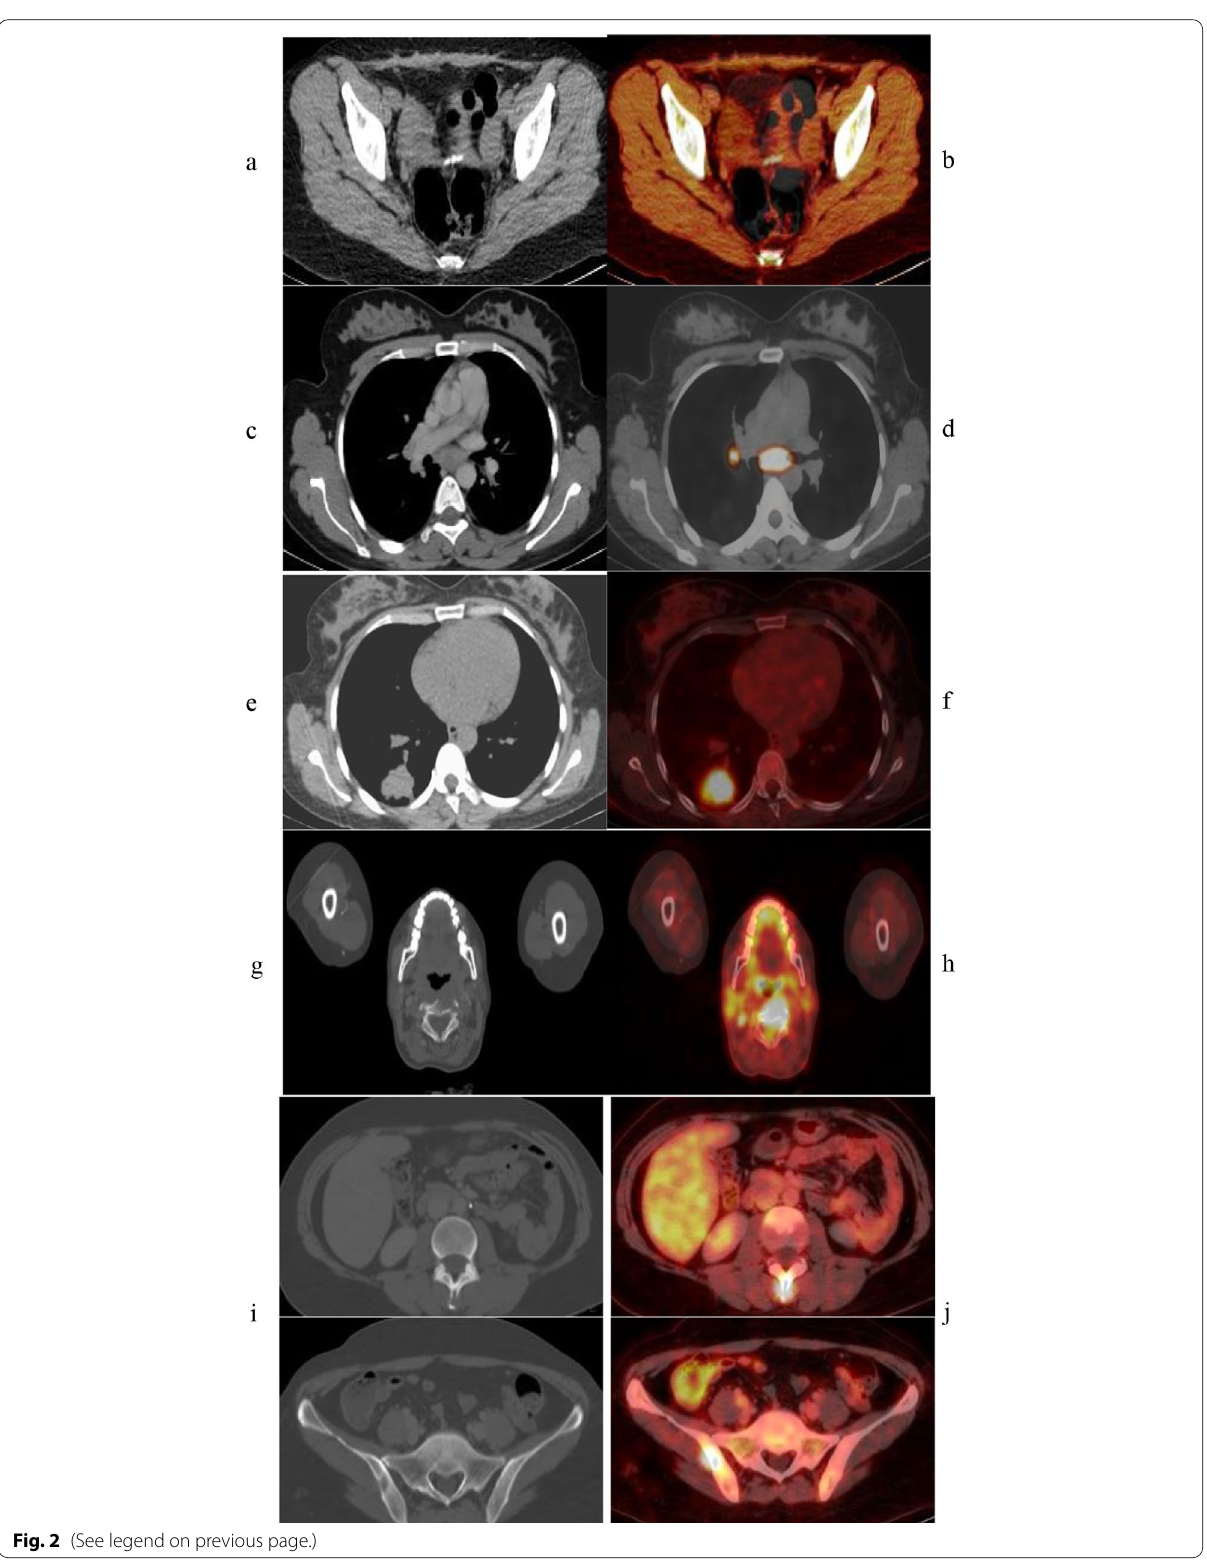
Fig. 2 (See legend on previous